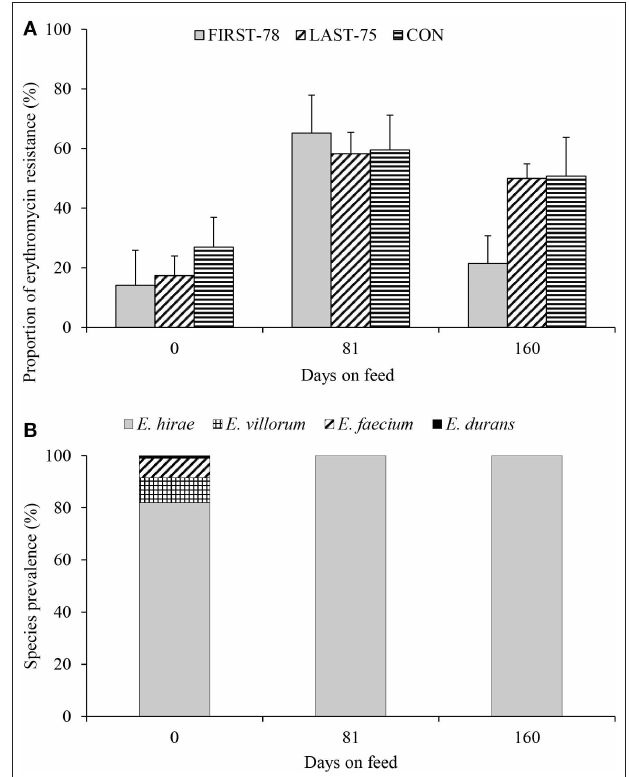
FIGURE 1 | Erythromycin resistance (A) and species prevalence (B) of enterococci isolated from the feces (sample 0, 81, 160 days) of feedlot cattle administered tylosin in the FIRST-78% , LAST-75% , or continuously ( CON ) during a 160 days feeding period. (A) Treatment group, P = 0.34; Treatment group X Days on feed, P = 0.37; Days on feed, P < 0.01. (B) Isolates are pooled across all pens, treatment groups and media